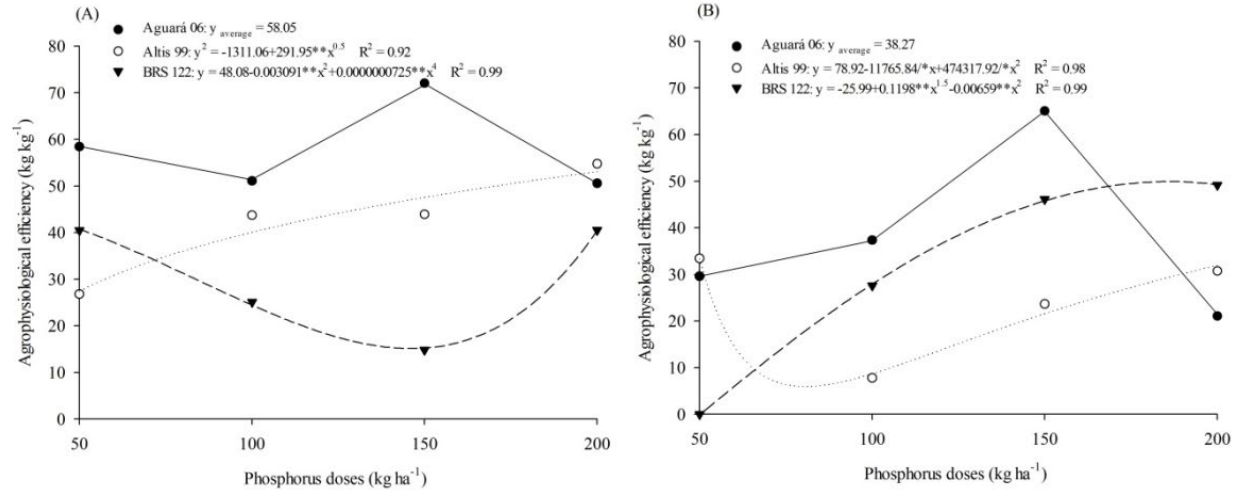
Figure 3. Agrophysiological efficiency of sunflower as a function of phosphorus doses in the 2016 agricultural harvest ( A ) and 2017 agricultural harvest ( B ).